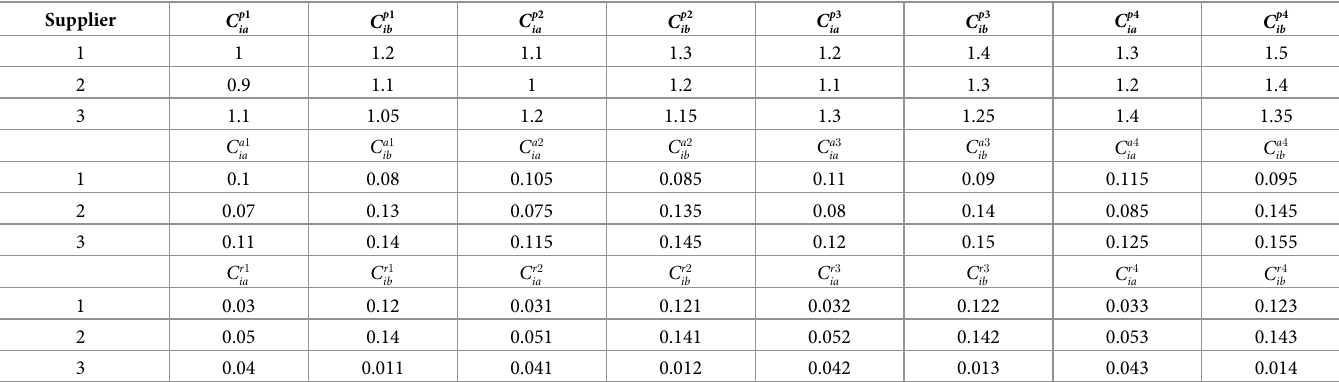
Table 5. Unit purchasing/transportation/administration cost.